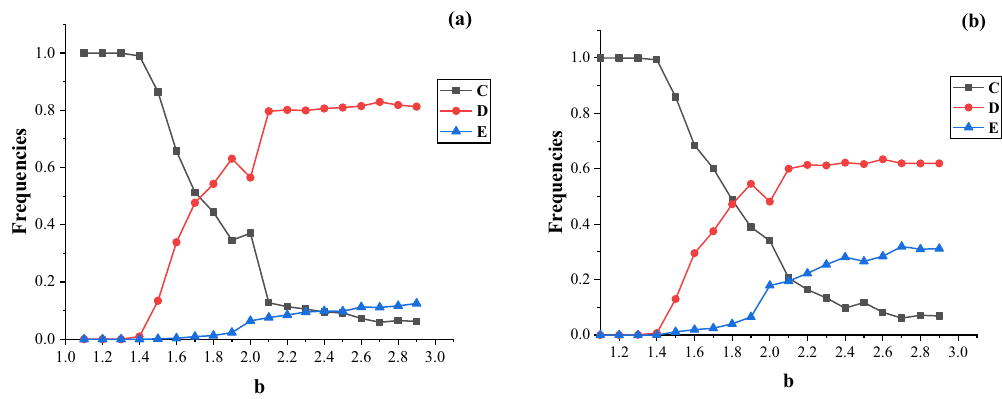
Figure 6. Frequencies of cooperation (C), defection (D), and extortion (E) as functions of benefit factor b for different value of extortion factor in steady state: ( a ) relatively fair extortioner ( χ = 1.5 ); ( b ) relatively unfair extortioner ( χ = 3 .). The game parameters b ∈ ( 1, 3] , m 1 = 2 , and c = 1 .